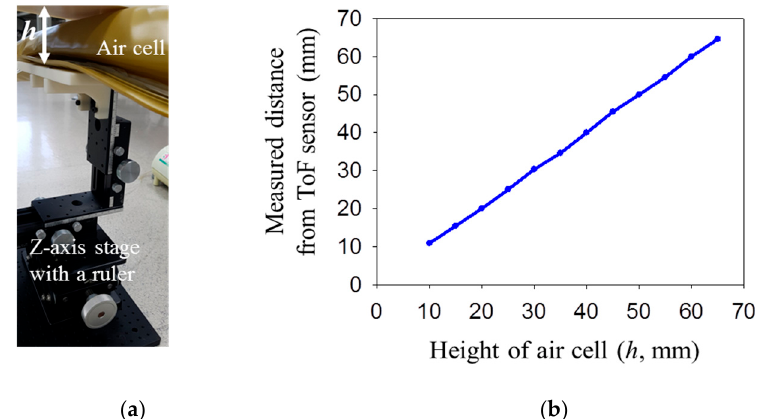
Figure 7. Measuring performance of the ToF optical sensor; ( a ) Setup for pressing the air-filled cell; ( b ) comparison of the measured distance by ToF optical sensor with actual height of air-filled cell by Z -axis stage.